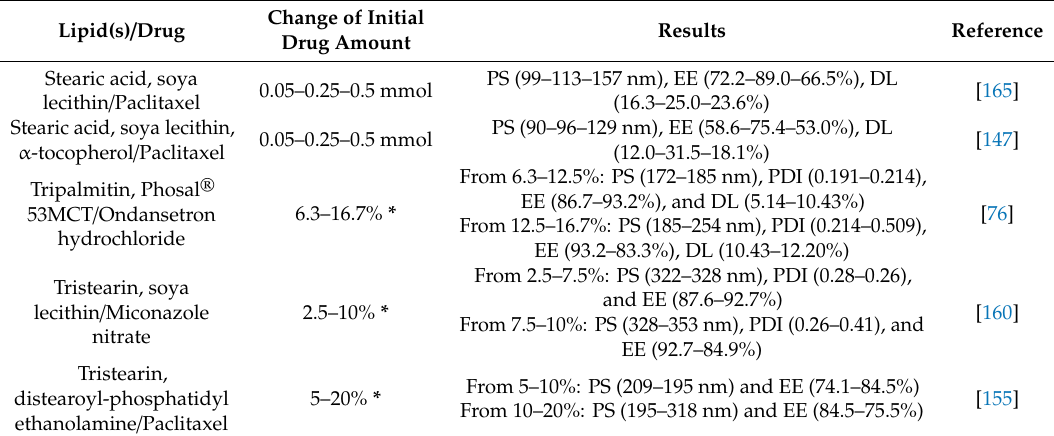
Table 5. E ff ects of initial drug amounts on the properties of SLNs and NLCs. Change of Initial Lipid(s) / Drug Drug Amount